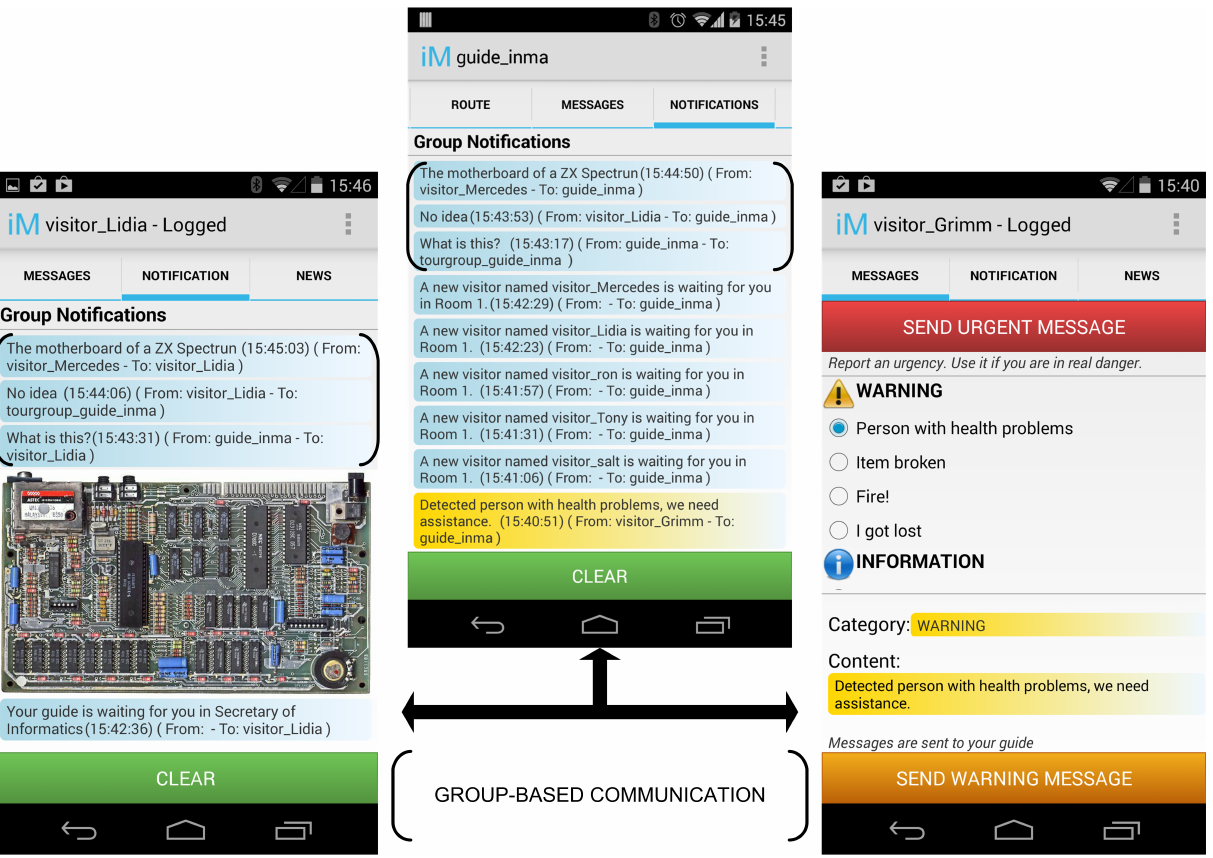
Figure 9. Screen shot notification tab of the guide and two visitors during a